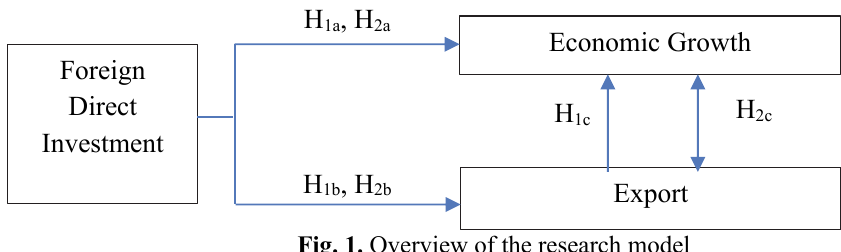
Fig. 1. Overview of the research